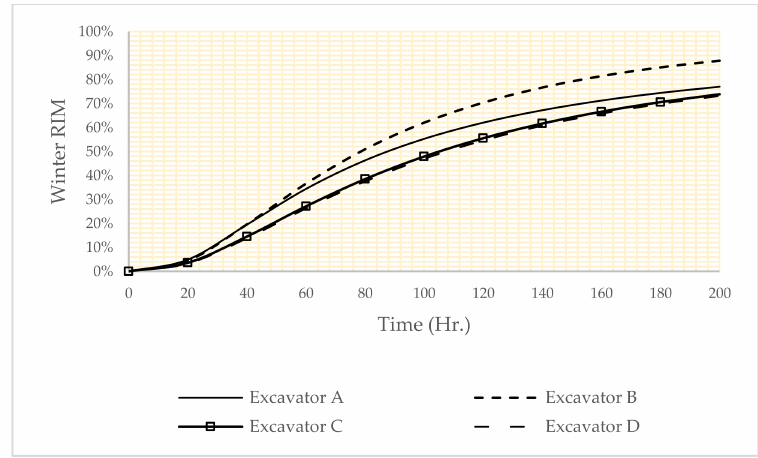
Figure 7. The results reliability importance measure in the winter